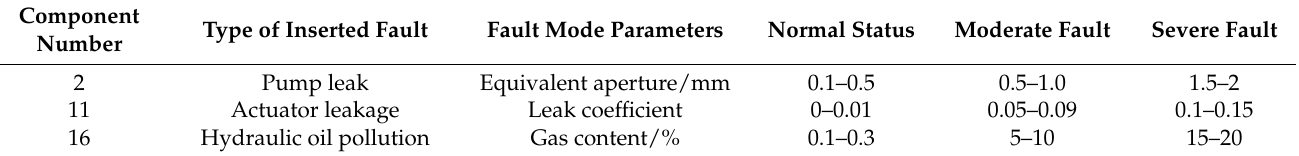
Table 2. Parameters of the fault mode